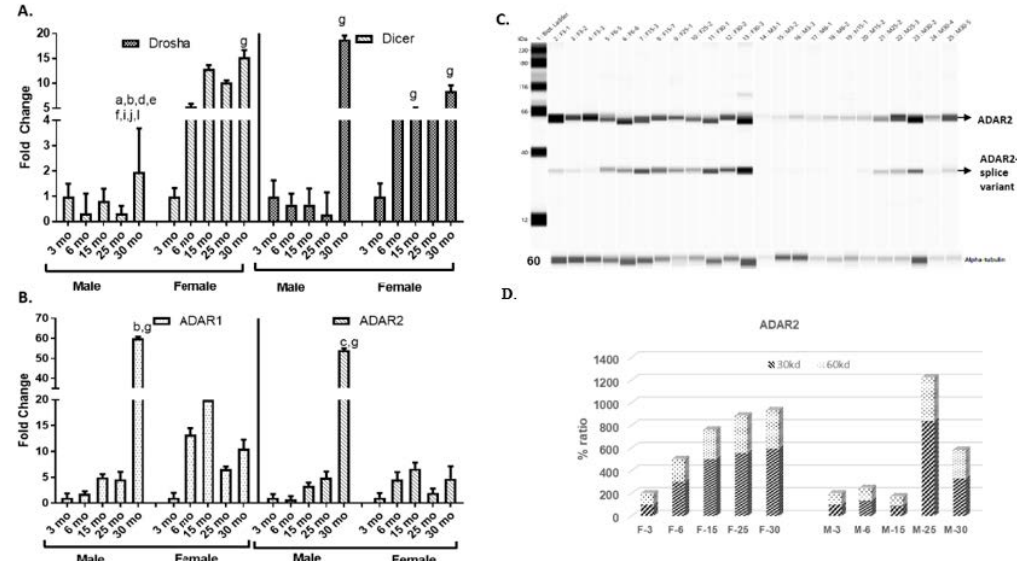
Figure 4. Expression levels of microRNA biogenesis and editing enzymes: ( A ) mRNA expression of Drosha and Dicer, the two enzymes involved in microRNA biogenesis determined in the visceral adipose tissue, showed higher expression in female rats compared to males. ( B ) mRNA expression of editing enzymes, Adenosine Deaminase Acting on RNA (ADAR1 and ADAR2), showed increasing levels with age in male rats. The female rats had higher expression of ADAR1 compared to ADAR2. ( C ) Protein expression of ADAR2 (60 kd) showed higher expression with age in both the sexes, but more prominent in female rats. ( D ) There was increased splice variant (30 kd) expression with age in both sexes. One-way analysis of variance (ANOVA) followed by post-hoc Tukey’s test. a p < 0.05 compared to M-3; b p < 0.001 compared M-6; c p < 0.05 compared M-6; d p < 0.001 compared to M-15; e p < 0.001 compared M-25; f p < 0.001 compared to F-3; g p < 0.05 compared to F-3; i p < 0.001 compared to F-6; j p < 0.001 compared to F-15; k p < 0.05 compared to F-15; l p < 0.05 compared to F-25.